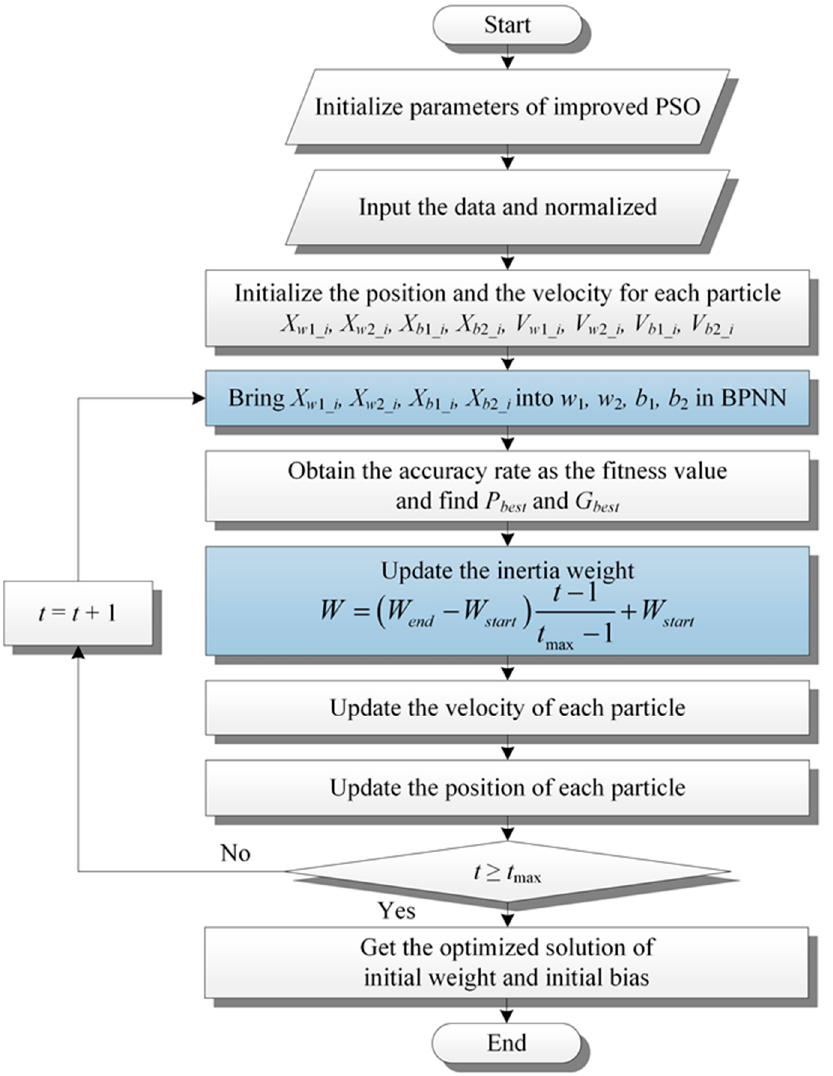
Figure 4. Construct of neural network.